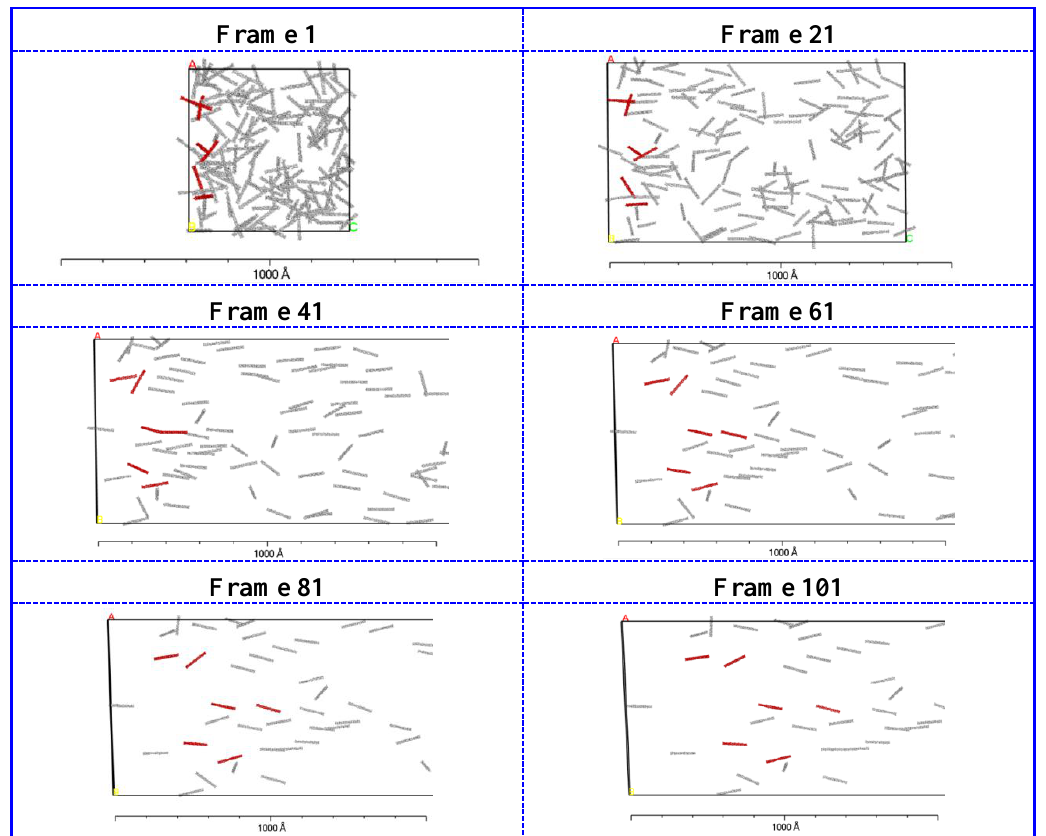
Figure 4. Simulation snapshots of CNTs/UHMWPE composites at 10% CNTs, obtained with a coupled rate of 1.0. The snapshots are taken every 2 × 10 4 timesteps.